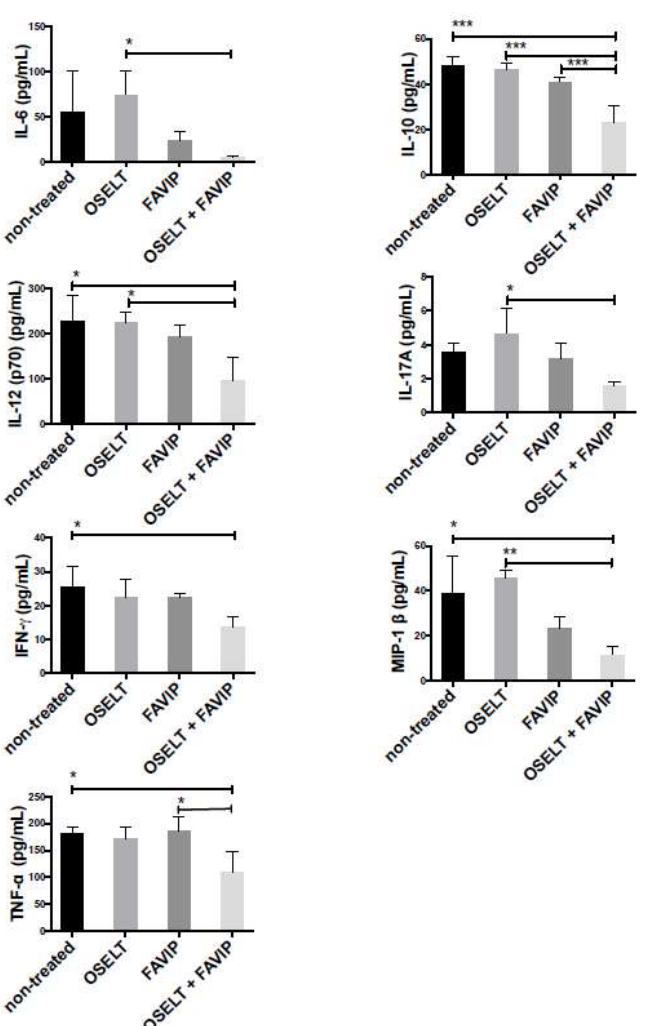
Figure 5. Pulmonary cytokine/chemokine levels on day 12 post-infection in IS C57BL/6 mice intranasally infected with 10 2 TCID 50 of rec A(H1N1)pdm09. Mice received meglumine (non-treated), 20 mg/kg of oseltamivir, 50 mg/kg of favipiravir or the combination by gavage BID for ten days, starting at 48 h post-infection (p.i.). Bars represent mean values ± SDs ( n = 3/group). One-way analysis of variance (ANOVA) with Tukey’s multiple-comparison post-test (* p < 0.05 and ** p < 0.01) was used for the